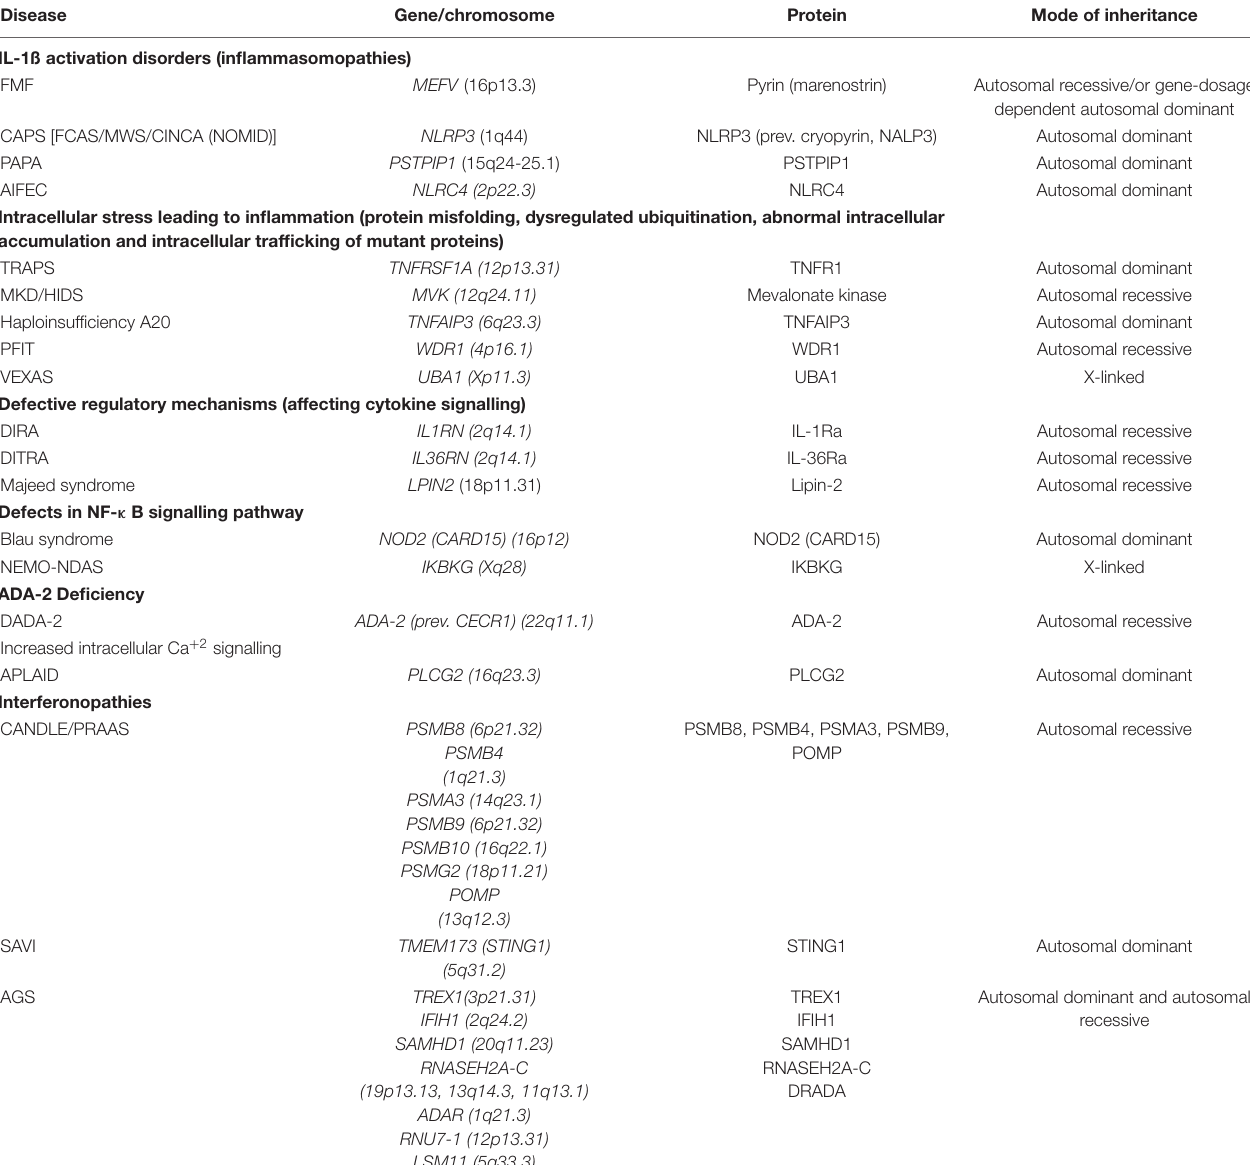
TABLE 1 | Monogenic systemic autoinflammatory diseases. Disease Gene/chromosome Protein Mode of